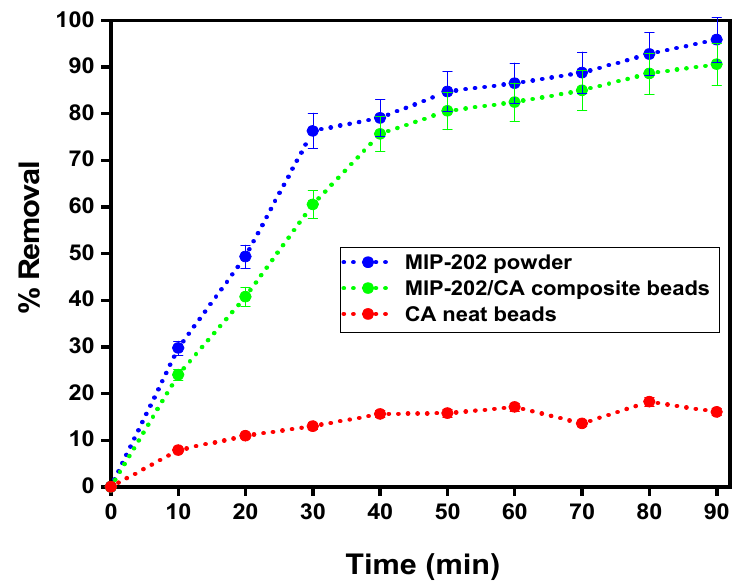
Figure 7. Effect of contact time on diazinon removal using MIP-202 powder, MIP-202/CA composite beads, and CA bio-beads at pH = 7, adsorbent dosage = 0.5 g/L, temperature = 22 °C, agitation speed = 300 rpm, and initial diazinon concentration of 50 mg/L .